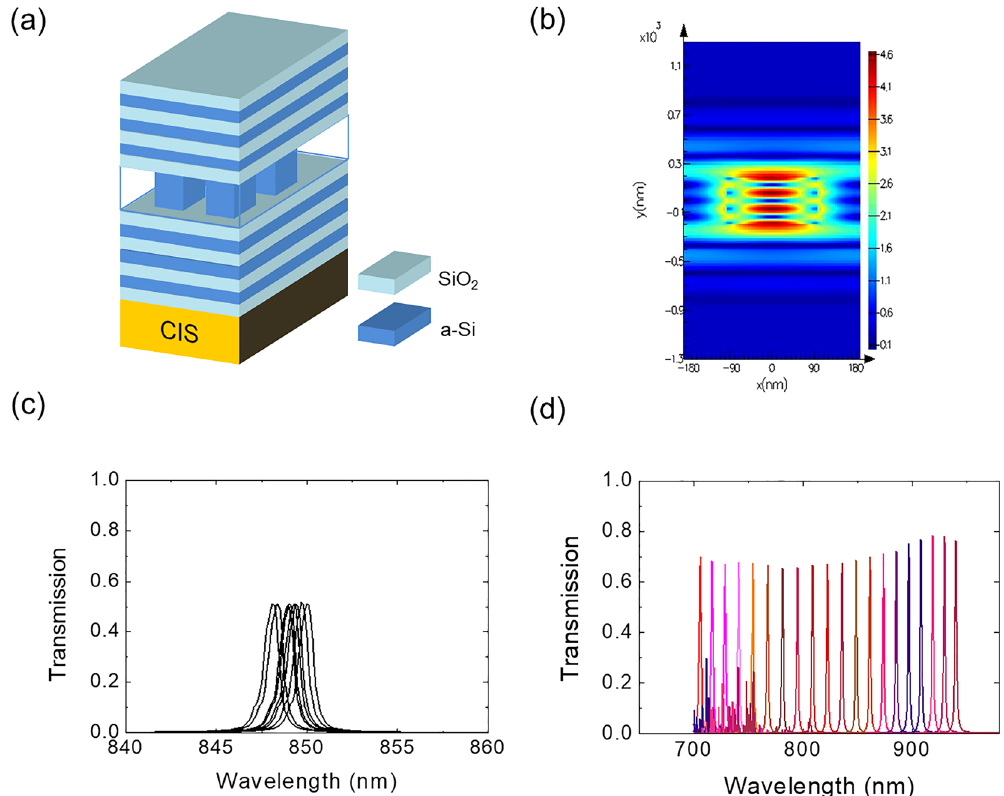
Figure 2: Metasurface bandpass filter array. (a) Schematic of the metasurface bandpass filter. (b) Calculated electric field map confined in the nanopost at the resonant wavelength. (c) Transmission spectra calculated with various etch profiles of posts. (d) Calculated transmission spectra of the nanopost-embedded bandpass filter